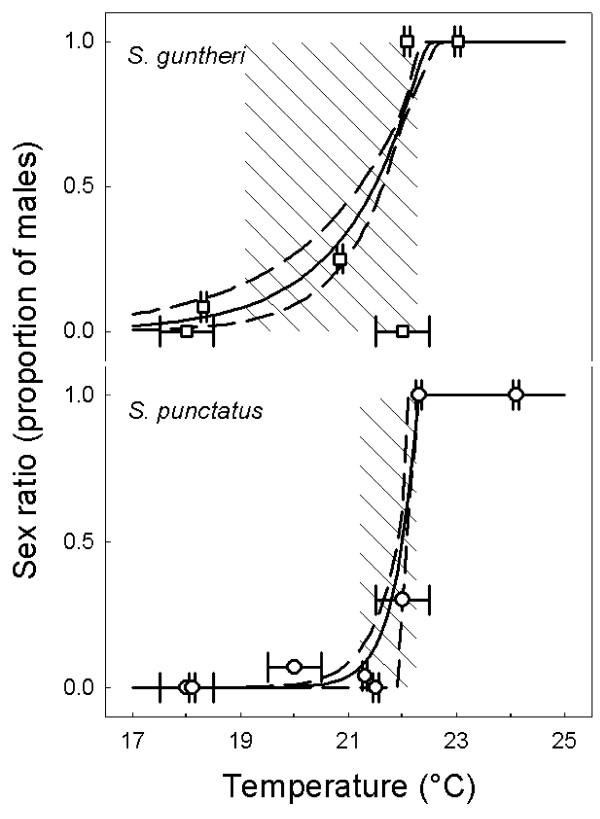
Relationship between incubation temperature and sex ratio (proportion of males) for two species of tuatara. Curves (—) are the theoretical function of sex ratio upon incubation temperatures maximizing the likelihood for two experimental data sets: those where incubation temperatures deviated by ± 0.1°C (small error bars) or ± 1°C (larger error bars) from mean temperatures. The TRT5–95% is indicated by the hatched lines and dashed lines are ± 2 SE.